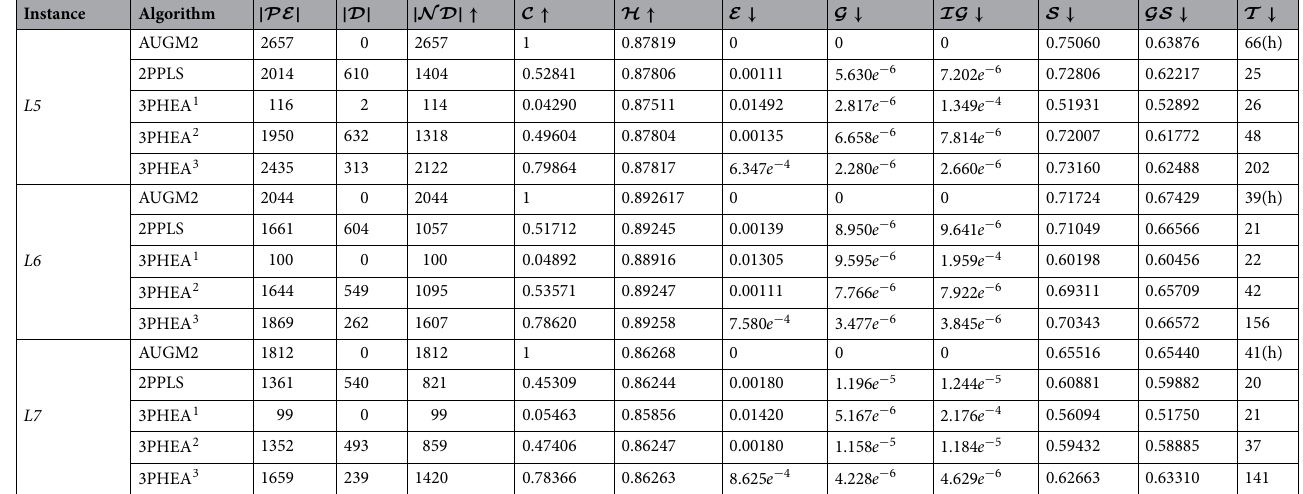
Table 4. Experimental results for datasets (Lust and Teghem 41 ). | PE | : Number of potentially efficient